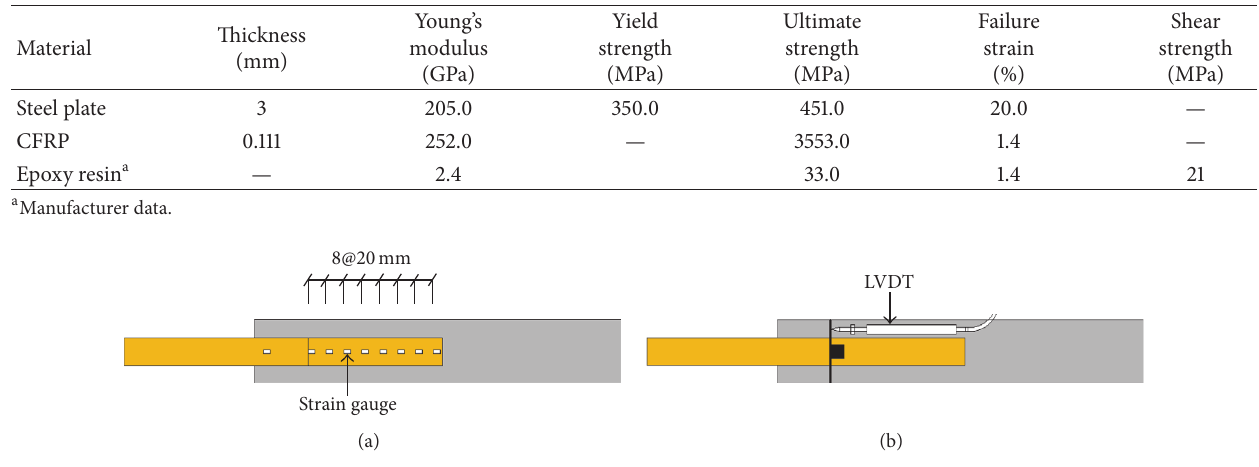
Figure 2: Instrumentation: (a) distribution of strain gauges; (b) layout of LVDTs.